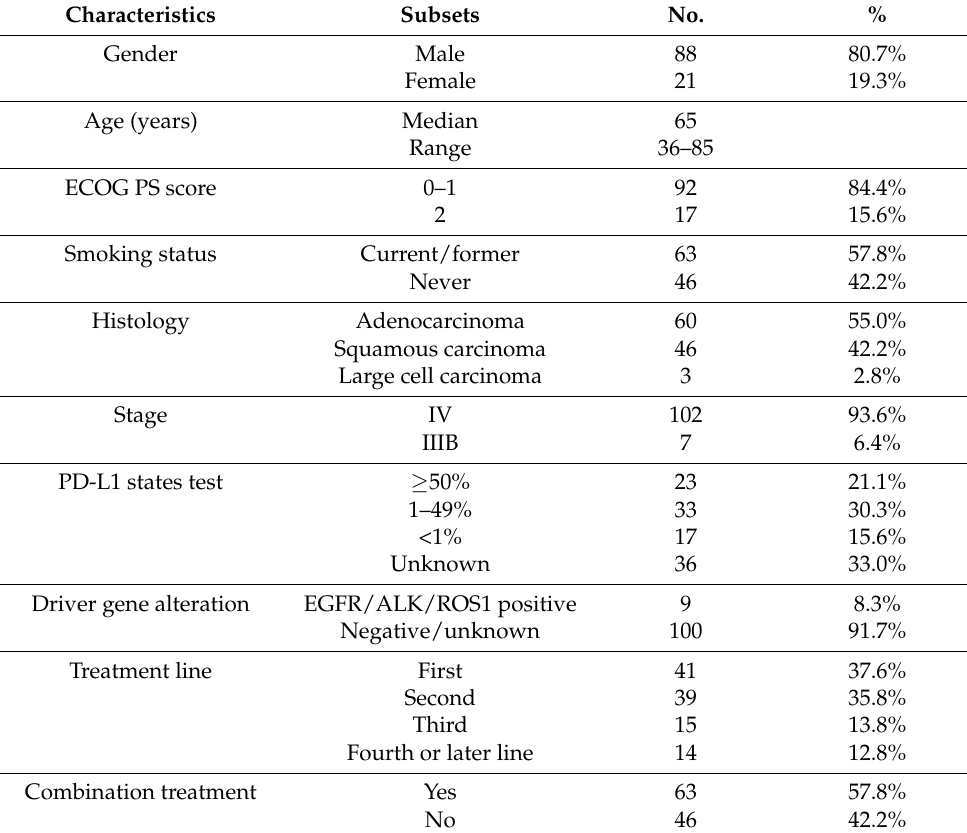
Table 1. Baseline characteristics of 109 advanced non-small cell lung cancer